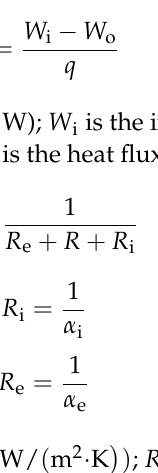
Figure 11. Specimens average surface temperature and heat flux.